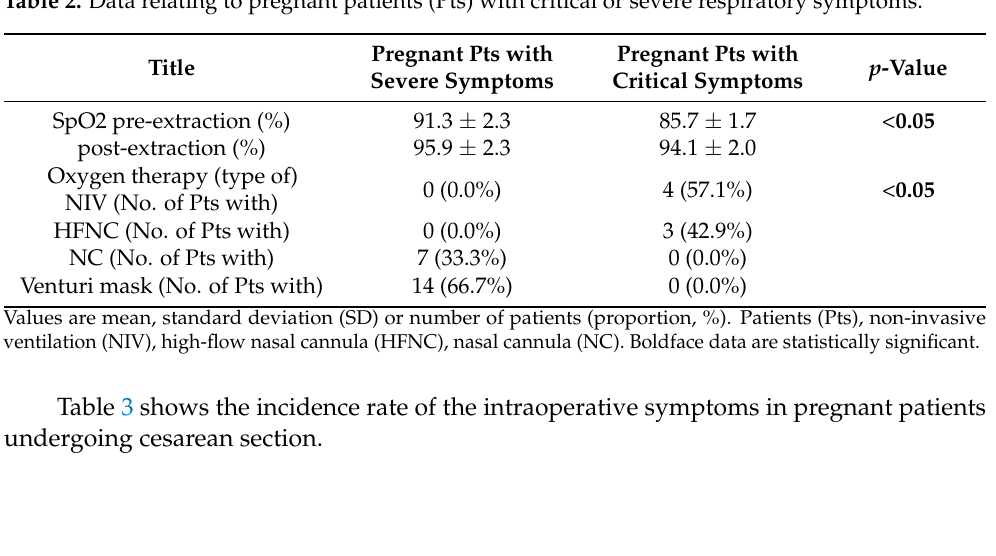
Table 2. Data relating to pregnant patients (Pts) with critical or severe respiratory symptoms.